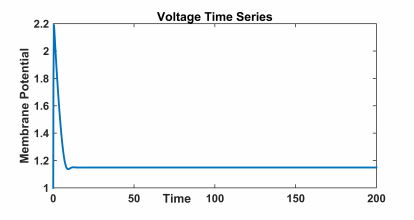
Figure 21. Responses of membrane potential with a constant external current value, I(t) = 5 µ A / cm 2 , a = 0.8 , b = 0.7 & c = 3